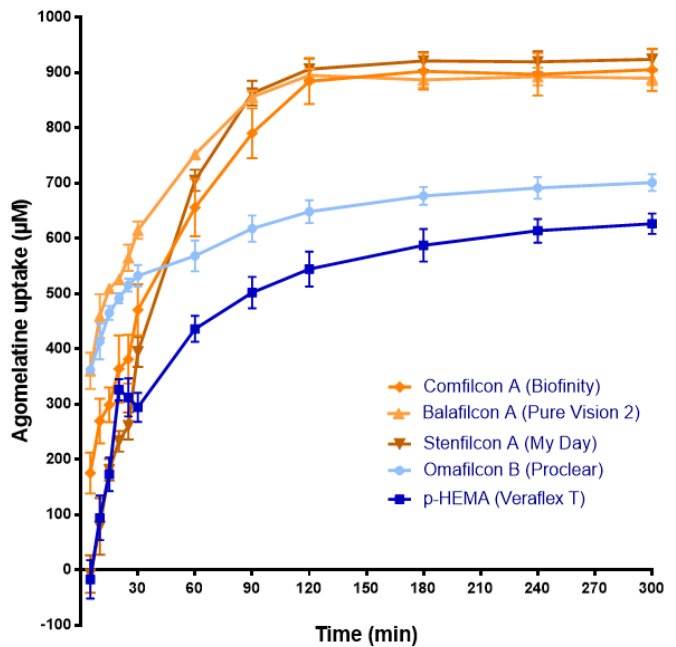
Figure 5. The agomelatine absorption by the CLs soaked with agomelatine solution (1 mL, 1 mM) over 300 min. The concentration ( µ M) values are presented as the mean ± S.D of n = 3 lenses per material. The blue color shows the release from CH CLs. The ochre color shows the release from SH CLs.